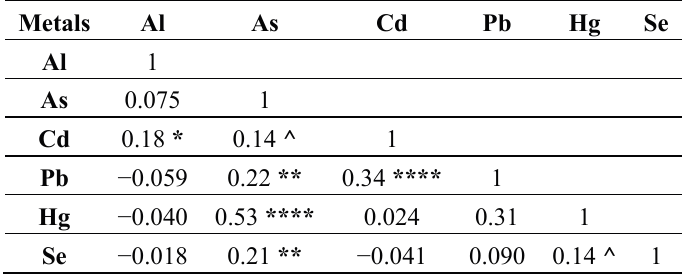
Table 3. Correlation matrix among Al, As, Cd, Pb, Hg, and Se in